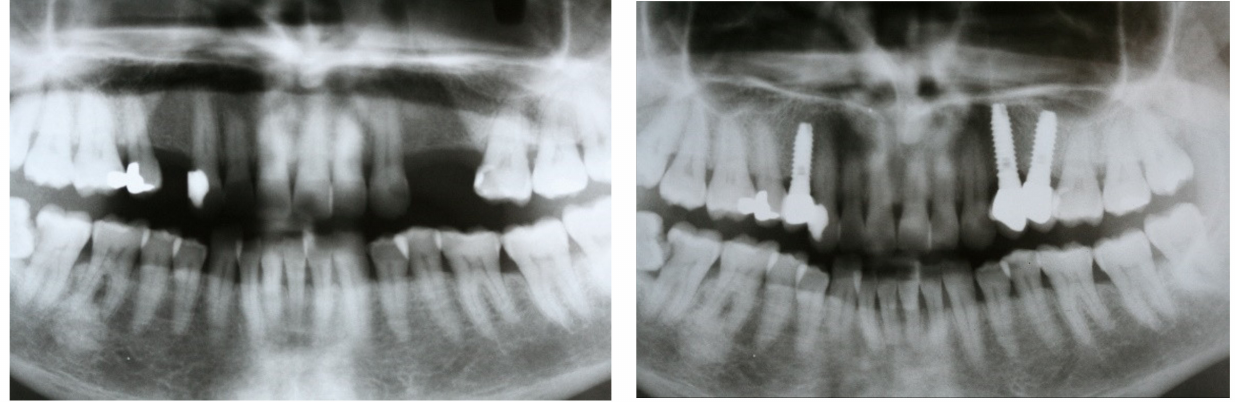
Figure 1. Panoramic radiographs were taken before treatment as part of the diagnosis and treatment plan and after implant placement and prostheses delivery.